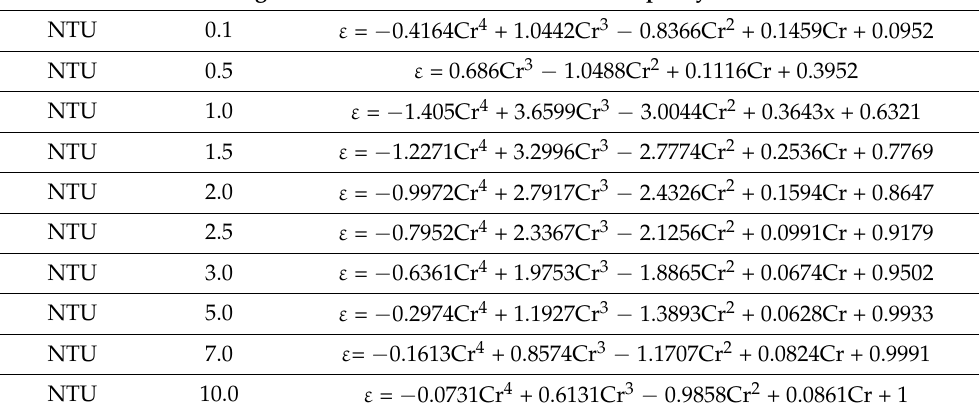
Table 6. Curve fit equations for effectiveness prediction—3-row pure cross flow heat exchanger. C min —External Fluid C max —Internal Fluid; sensible heat